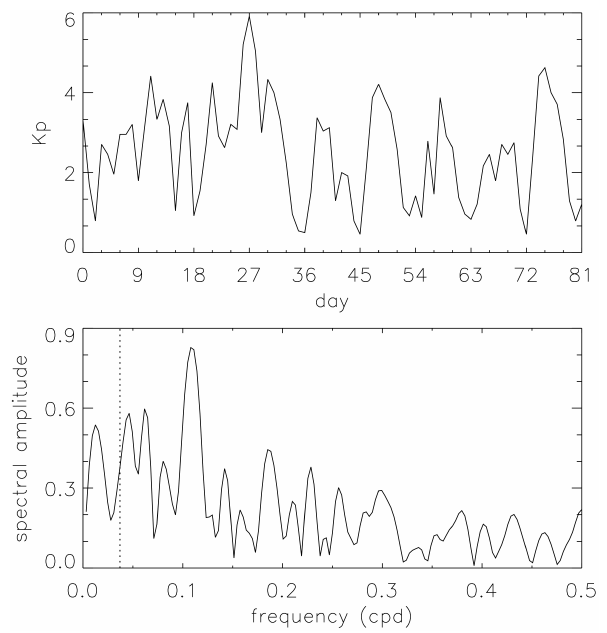
Figure 7. Top: daily averaged Kp index. Bottom: its Lomb–Scargle spectrum. The dotted vertical line corresponds to a period of 27 days.